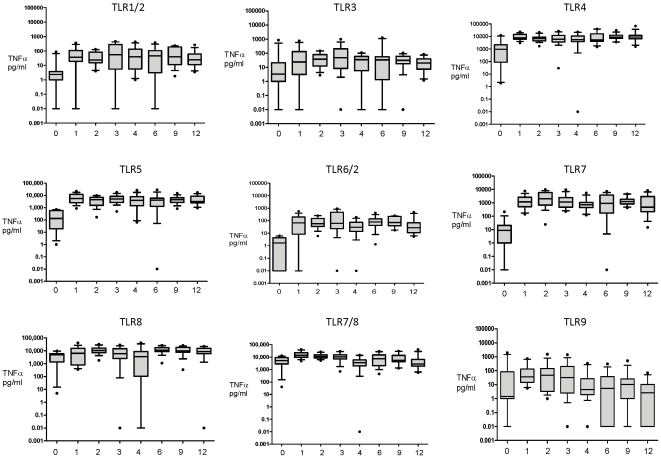
Net TLR-mediated TNFα responses differ between agonists and
across the first year of life.100 µl of whole blood was cultured overnight with each of the TLR
agonists at birth, 1, 2, 3, 4, 6, 9 and 12 months of age (x axis) and
TNFα cytokine production (y axis) was measured as described in the
Materials and Methods (pg/mL).
Unstimulated values are subtracted from stimulated values and presented
as box and whisker plots, n = 12-15.